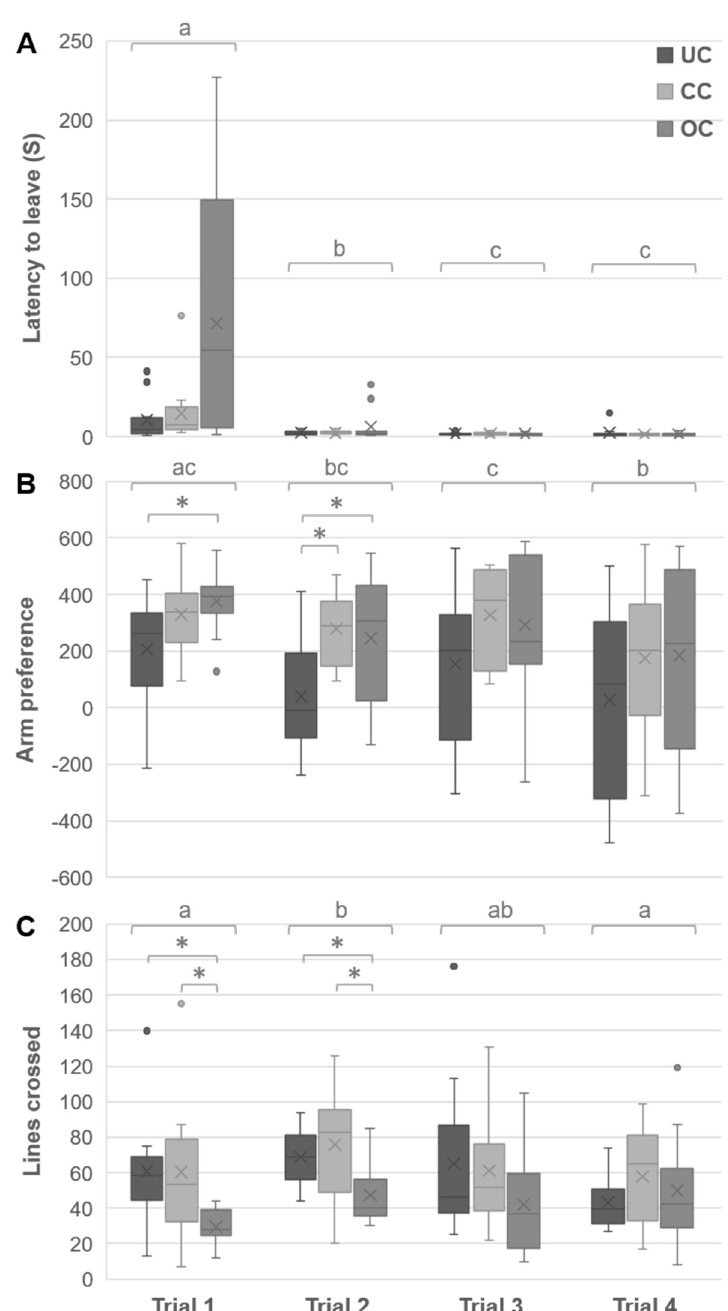
Figure 5. Effects of housing density on Y-maze behavior. The latency to leave the start-box ( A ), arm preference; with 0 indicating no preference, a positive value indicating the time spent more in the social arm, and a negative value indicating the time spent more in the foraging arm, in s ( B ), and number of lines crossed ( C ) of eight-week old chicks during the Y-maze test are depicted. Letters indicate trial differences across the groups, and asterisk indicate group differences within trials. The box ranges from the first to the third quartile, line indicates the median and cross indicates the mean, whiskers represent minimum and maximum without outliers, * p < 0.05, ** p < 0.01 (UC = undercrowding, CC = conventional crowding, OC = overcrowding condition).